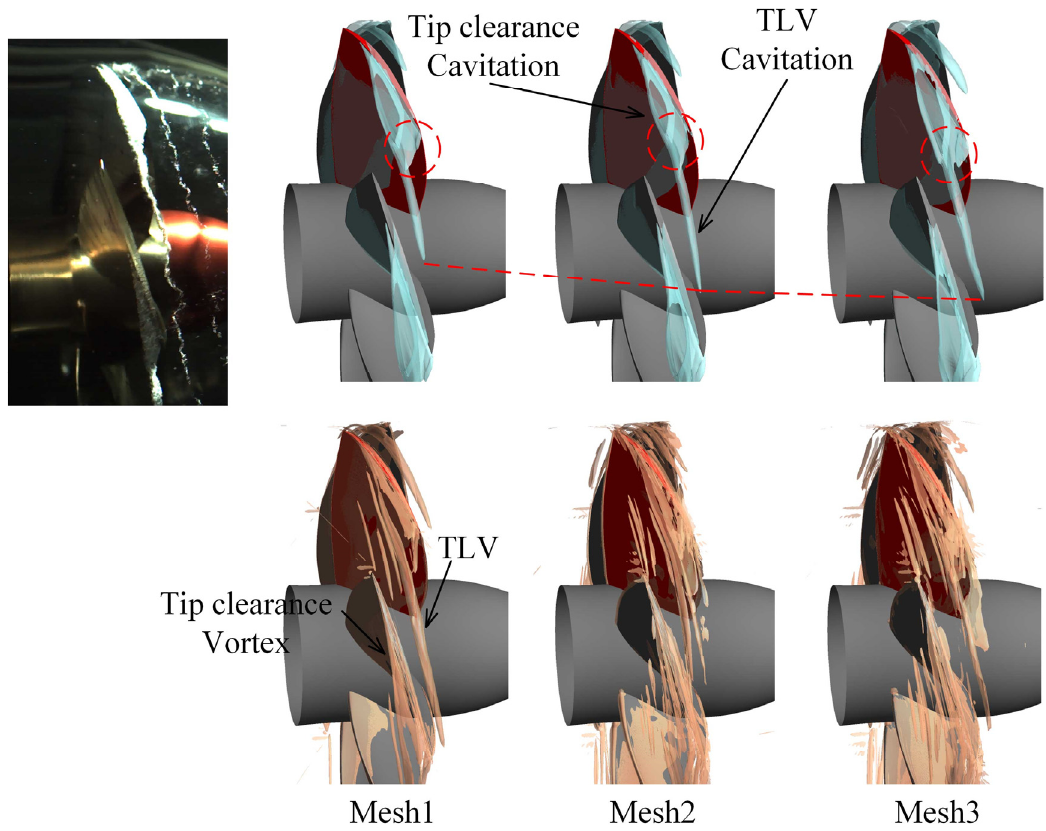
Figure 4. Comparison of the numerical and observed cavitation snapshots and vortex structure at a certain moment (The upper row is the isosurface of α v = 0.1, the lower row is the isosurface Q criterion, Q = 2 × 10 6 ) [42].